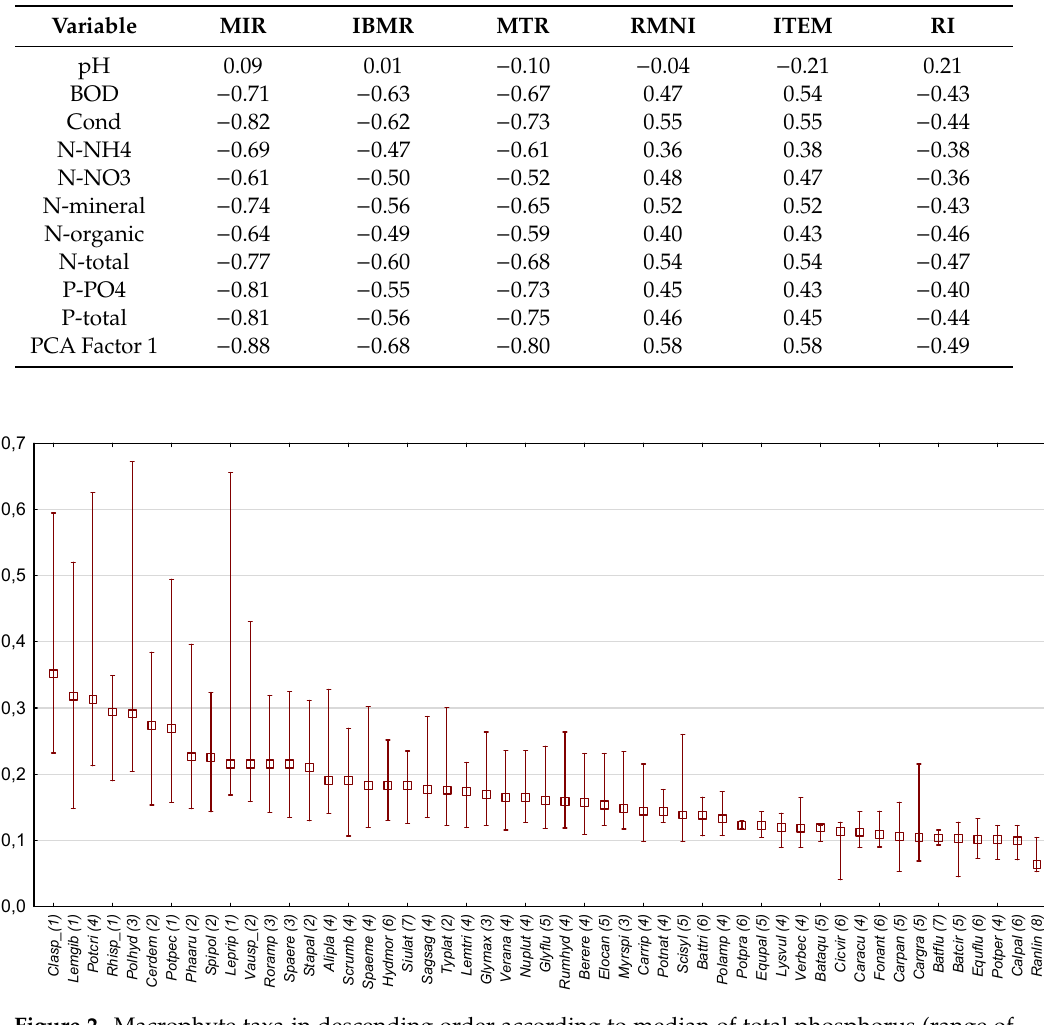
Figure 2. Macrophyte taxa in descending order according to median of total phosphorus (range of quartiles marked). Abbreviations of macrophytes are explained in Table S2. Macrophyte Index for Rivers (MIR) indicator values ( l ) are shown in brackets.